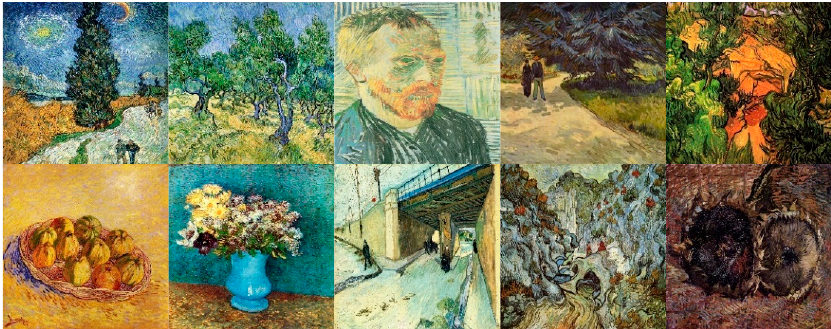
Figure 4. Examples of Van Gogh style image collections.